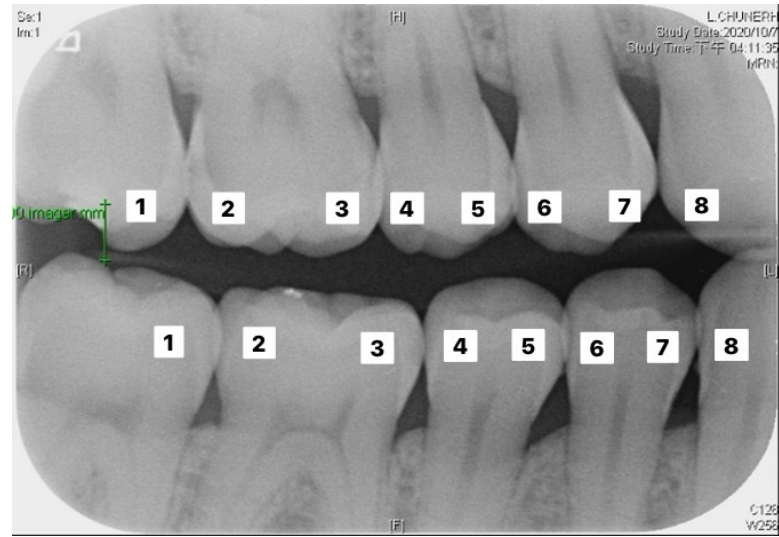
Figure 9. Image example of outer teeth for validation (from left to right, in order of 1–8). Tables 6 and 7 correspond to the judgment of the upper and lower rows of teeth in Figure 10. Results show that the accuracy of the proposed model for judging the restorations was 95.56%, which is an improvement compared to Lin et al. [30], with an accuracy of 90.23%. The proposed method in Lin et al. [30] first enhanced the classification features of the image, and then added the regular term and impulse, before establishing a CNN model with the ReLU function. With regard to judging caries, the proposed model in this study showed an accuracy of 90.30%, which was also an improvement compared to Singh and Sehgal [31], with an accuracy of 80.00%, which used a neural network classifier to classify caries. Tables 8 and 9 are the truth tables of different CNN models.